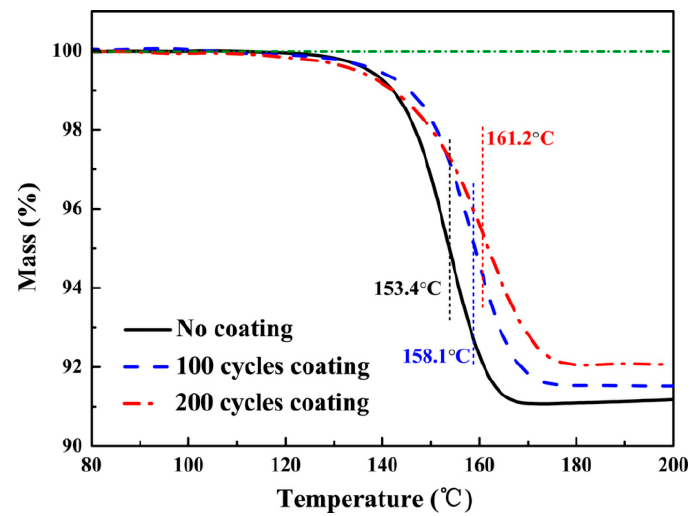
Figure 12. (Color online) TG curves of AlH 3 and AlH 3 @Al 2 O 3 samples at the heating rate of 2 °C/min. Reprinted with permission from ref. [68]. Copyright 2017 American Vacuum Society.